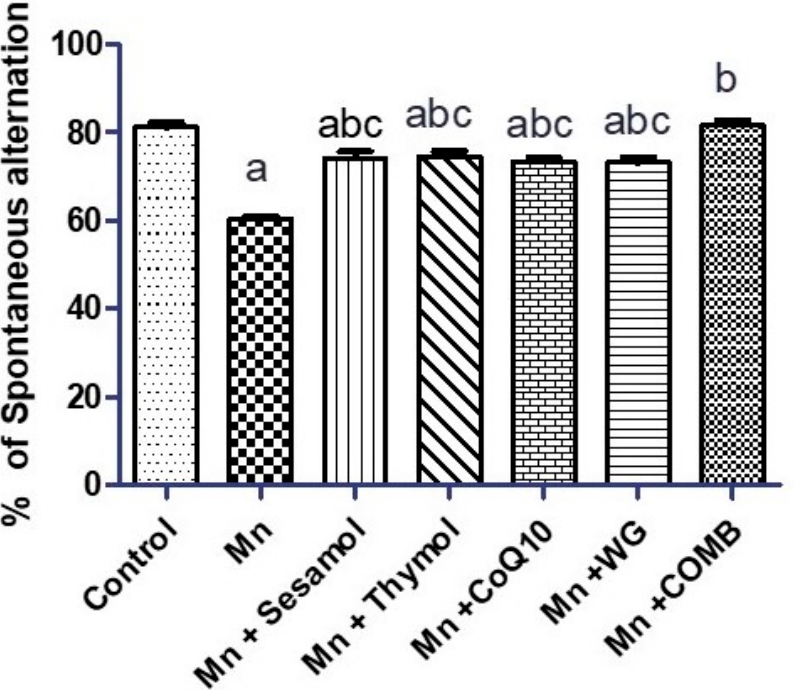
Figure 3. Effects of sesamol, thymol, CoQ10, wheat grass, or their combination on spontaneous alternation percent in Y-maze test of rats treated with MnCl 2 . Values are means of 12 rats ± S.E.M, as compared with control (a), Mn (b), and COMB (c) groups. One-way ANOVA with posttest Tukey’s multiple comparison assessed the statistical differences between the various groups, p -value < 0.05 .